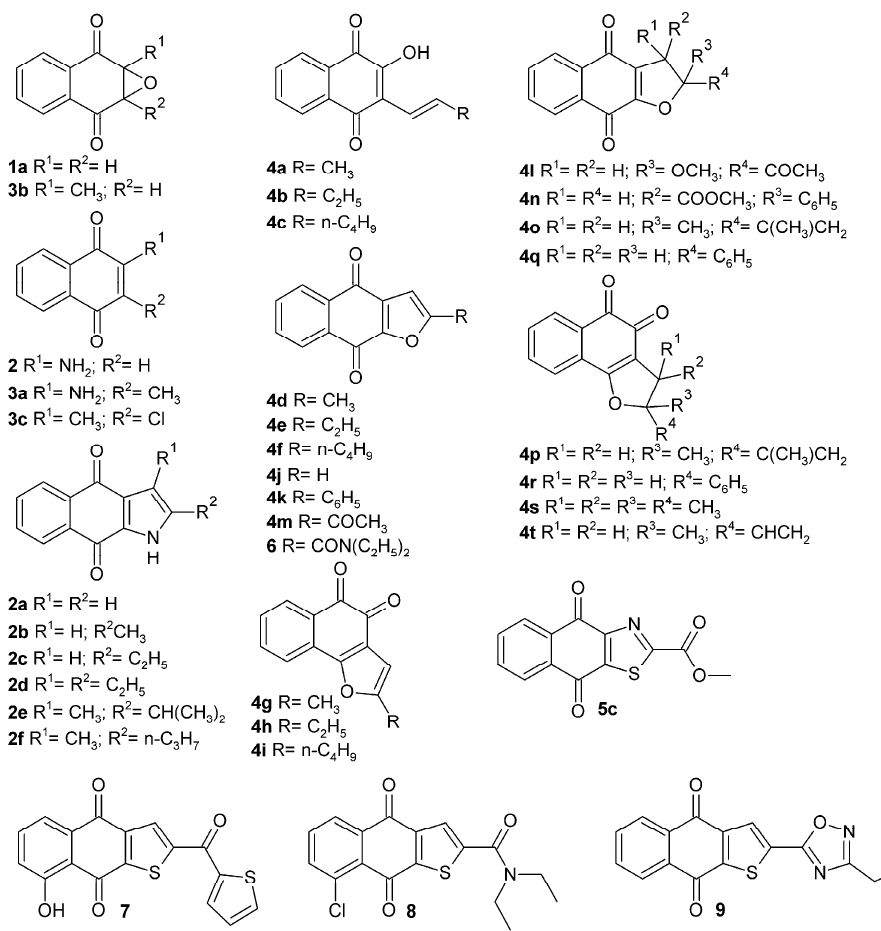
Figure 1. Naphthoquinone derivatives designed, synthesized and evaluated in this study.